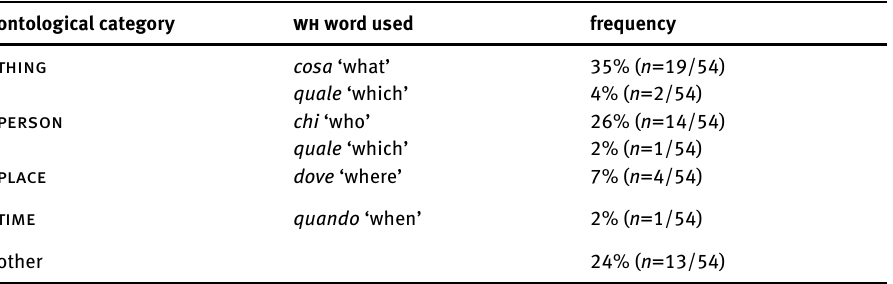
Table 4: Frequencies of restricted repair initiators requesting clarification that feature wh words, distinguished by ontological